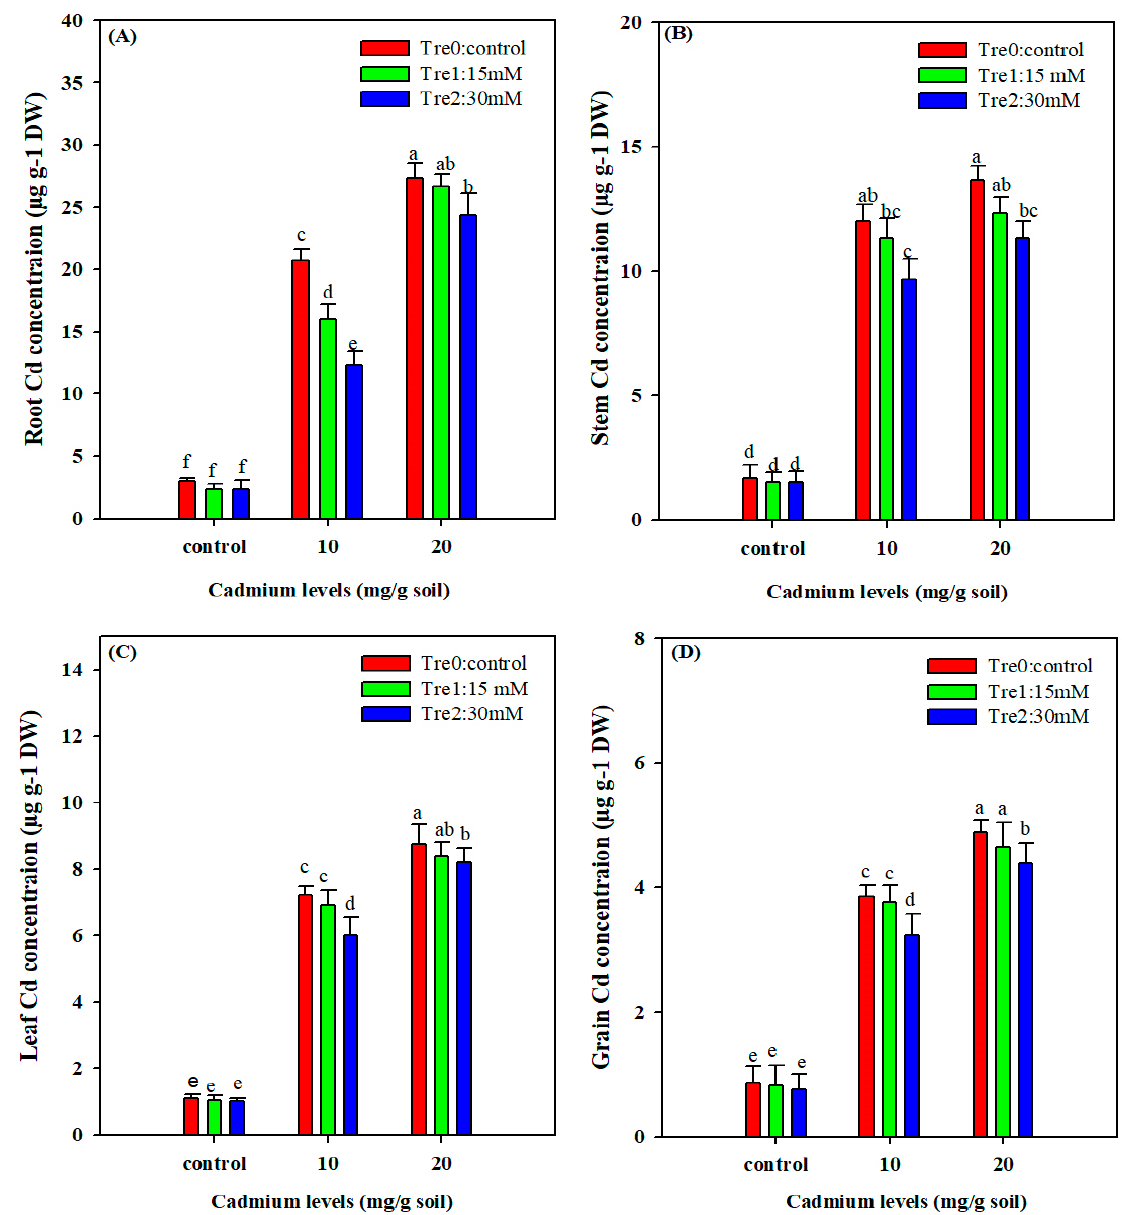
Figure 5. Effect of foliar spray of Tre on Cd concentration in the root ( A ); stem ( B ); leaf ( C ); and grain ( D ). Cd contents of mung bean plant grown under Cd stress. The values given in vertical bars are showing the mean of three replicates with ± S.E and the different letters above the bars under the same treatment show the significant differences at p < 0.05.